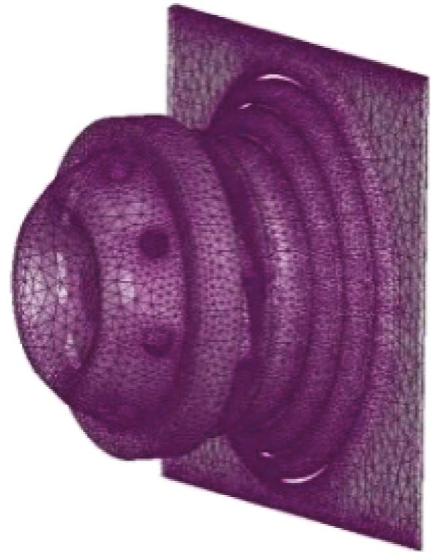
Figure 9: Grid of the swirl cup.